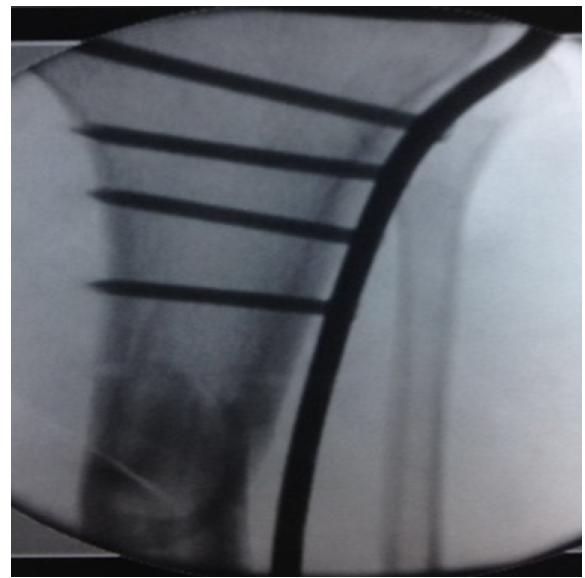
Figure 2. Proximal end of the plate fi xed to the proximal tibia in a proper